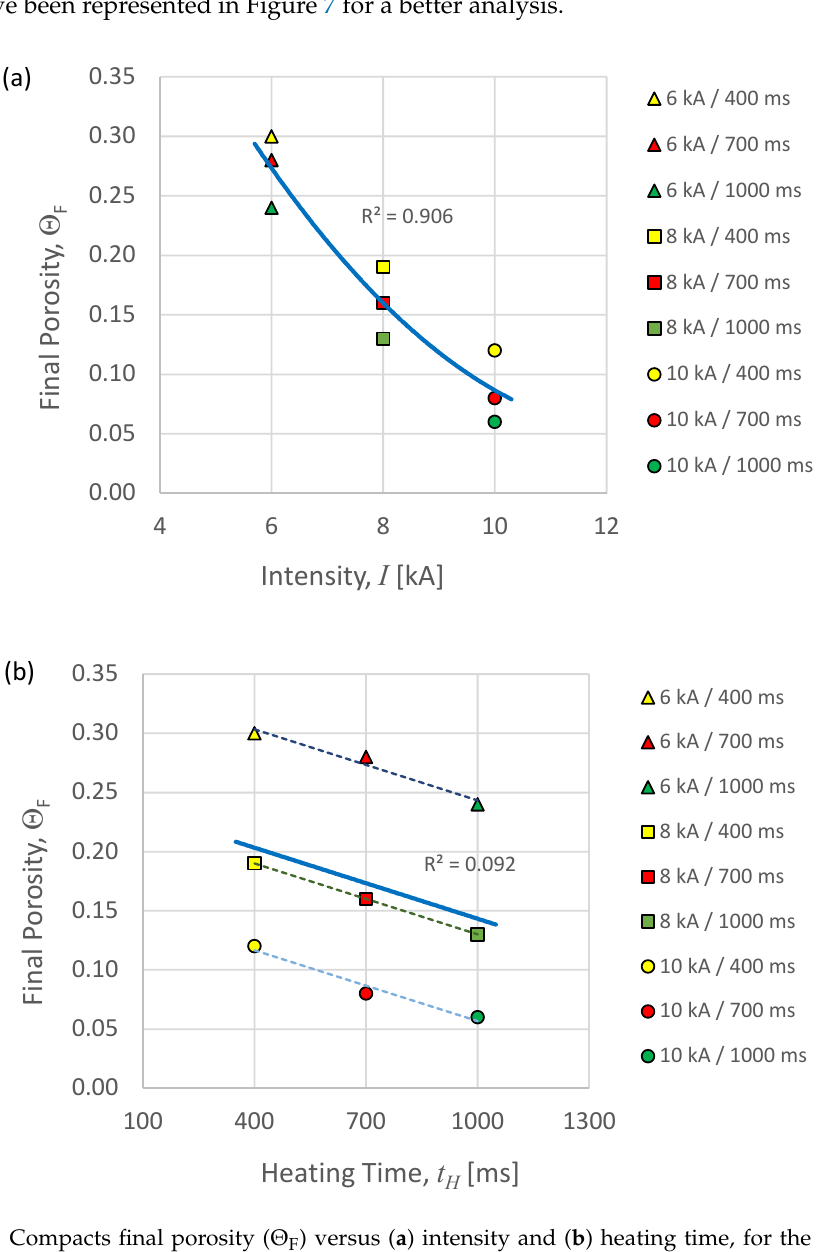
Figure 7. Compacts final porosity ( Θ F ) versus ( a ) intensity and ( b ) heating time, for the different MF-ERS experiments. The continuous lines in both graphs represent the trend of the whole data cloud. The discontinuous lines in ( b ) describe the trends of experiences carried out with the same current intensity.